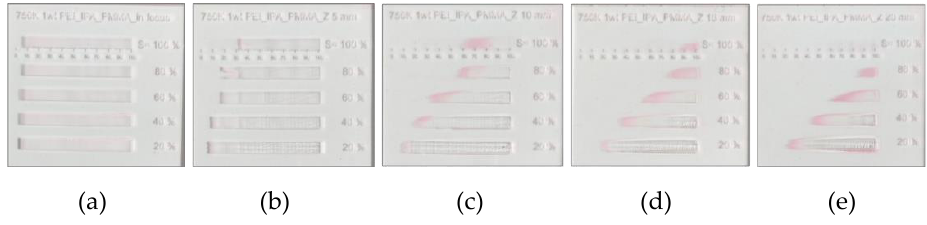
Figure 4. Investigation into the optimum conditions of chemical reactions with different laser power and scan speed according to the Z positions. Experimental results after Eosin Y binding in different Z positions ( a ) in focus, ( b ) Z = 5 mm, ( c ) Z = 10 mm, ( d ) Z = 15 mm, and ( e ) Z = 20 mm, respectively. Gray wedge according to Experimental Section.